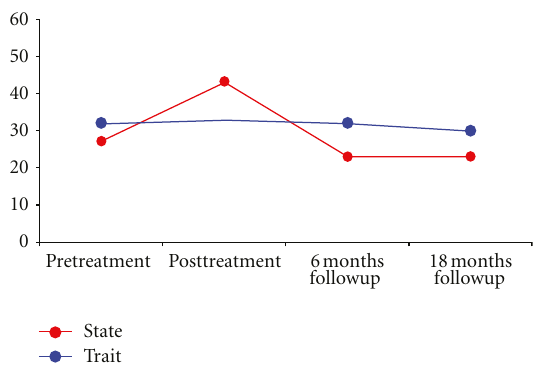
Figure 4: Spielberger State-Trait Anxiety Inventory pre- and post- treatment and follow up.